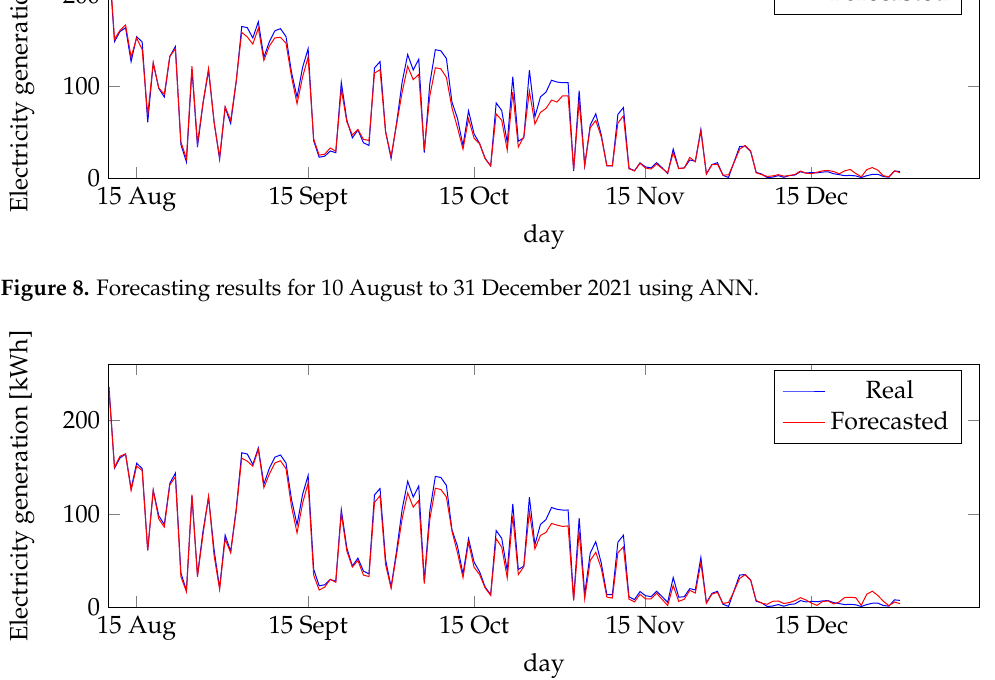
Figure 9. Forecasting results for 10 August to 31 December 2021 using LassoR.